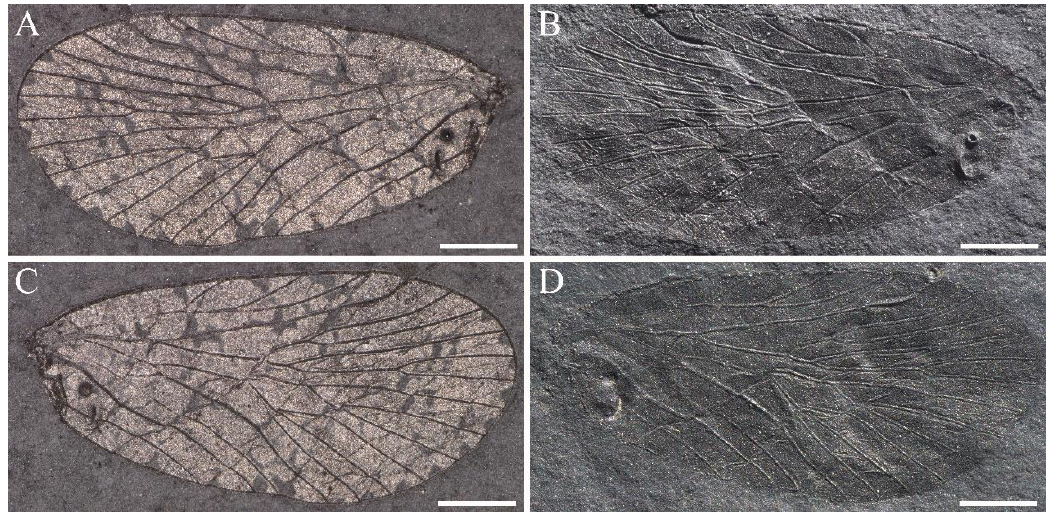
Figure 8. Sinoagetopanorpa lini sp. nov., NIGP200917 (paratype). ( A , B ) Photographs of part; ( C , D ) Photographs of counterpart; ( A , C ) were taken when specimens were immersed under 70% alcohol in vertical reflected light; ( B , D ) were taken in oblique reflected light. Scale bars represent 1 mm in ( A – D ).